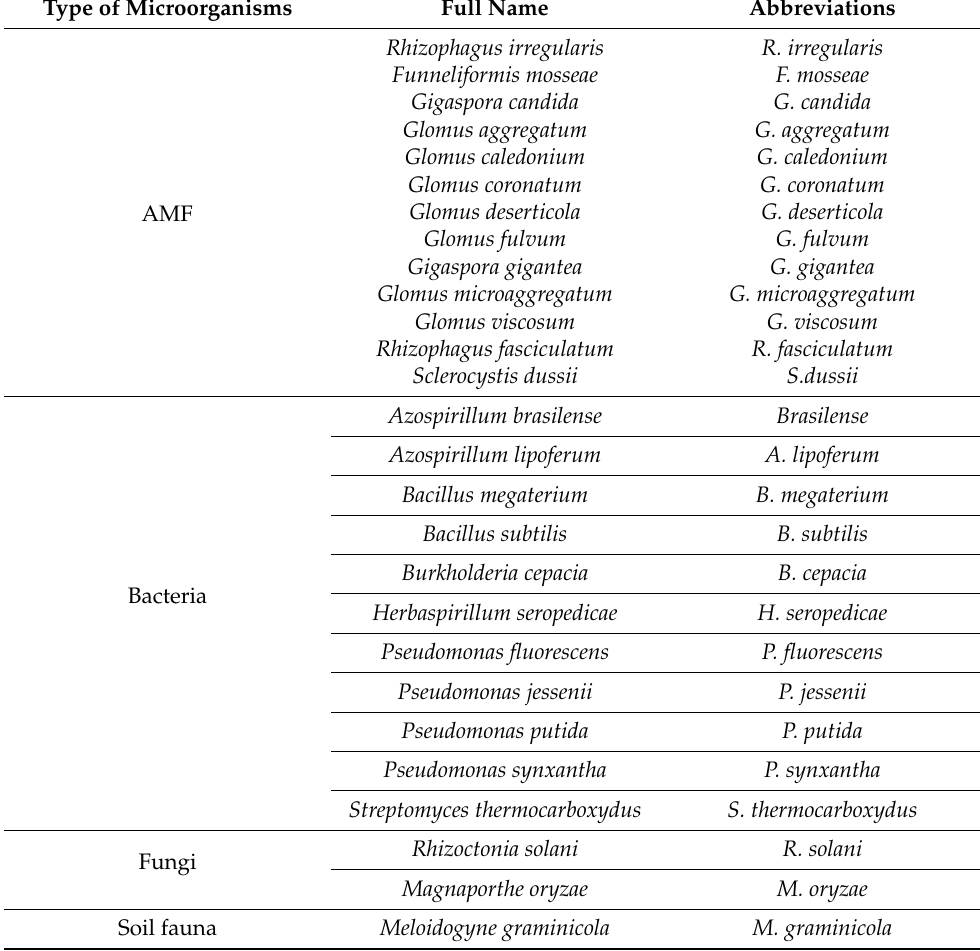
Table 2. List of abbreviations for AMF and other